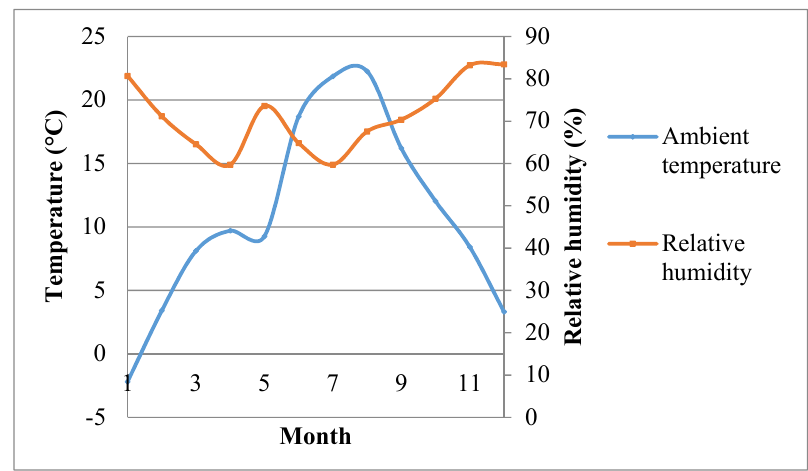
Figure 15. The relations for ambient temperature and relative humidity during the year.